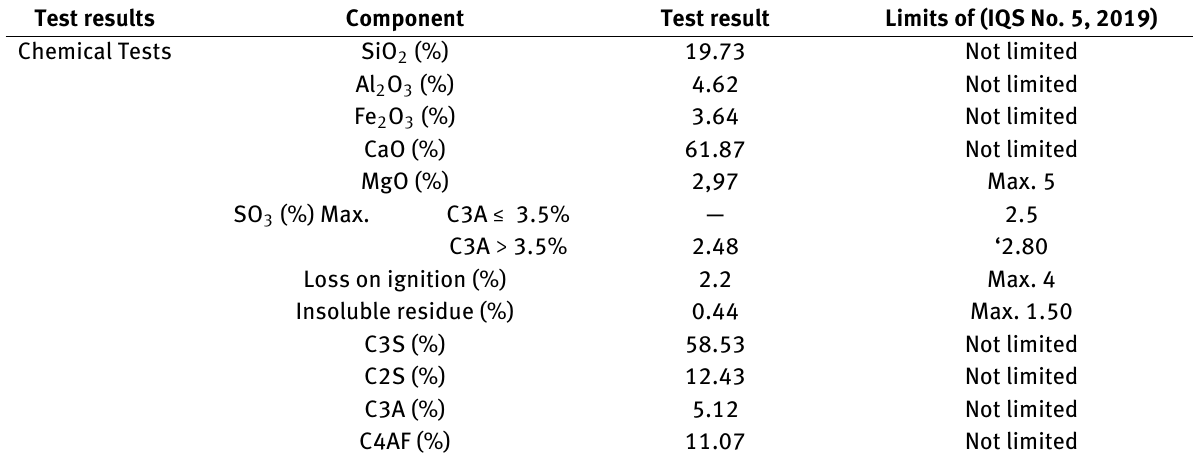
Table 2: Chemical composition of cement Test results